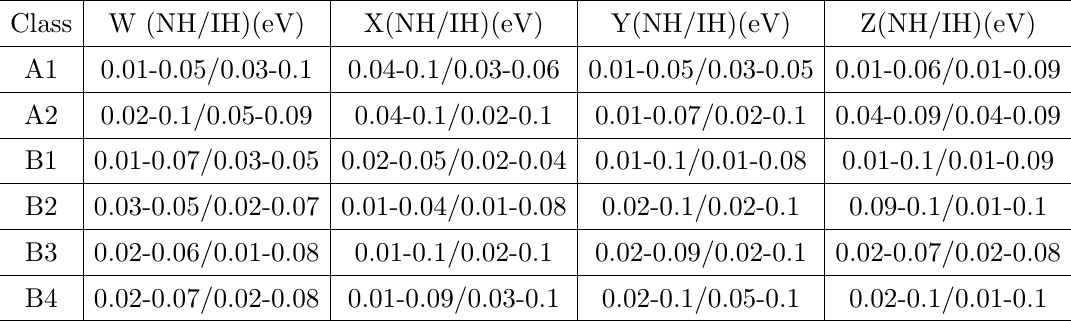
Table 8 . The range of model parameters that satis(cid:12)es the KamLAND-Zen limit of e(cid:11)ective Majo- rana neutrino mass.